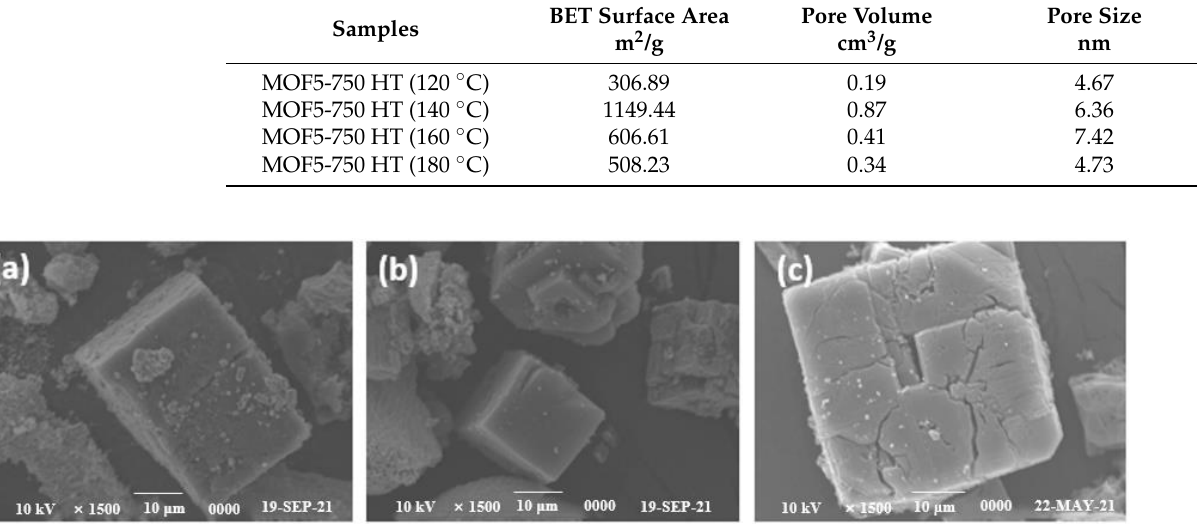
Figure 6. SEM images of catalysts: MOF5-700 ( a ), MOF5-750 ( b ), MOF5-800 ( c ).